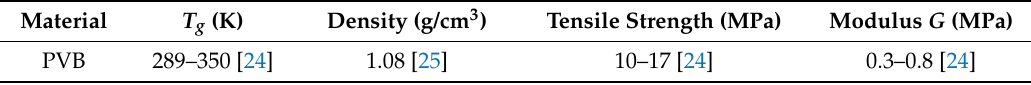
Table 1. Physical and mechanical properties of PVB